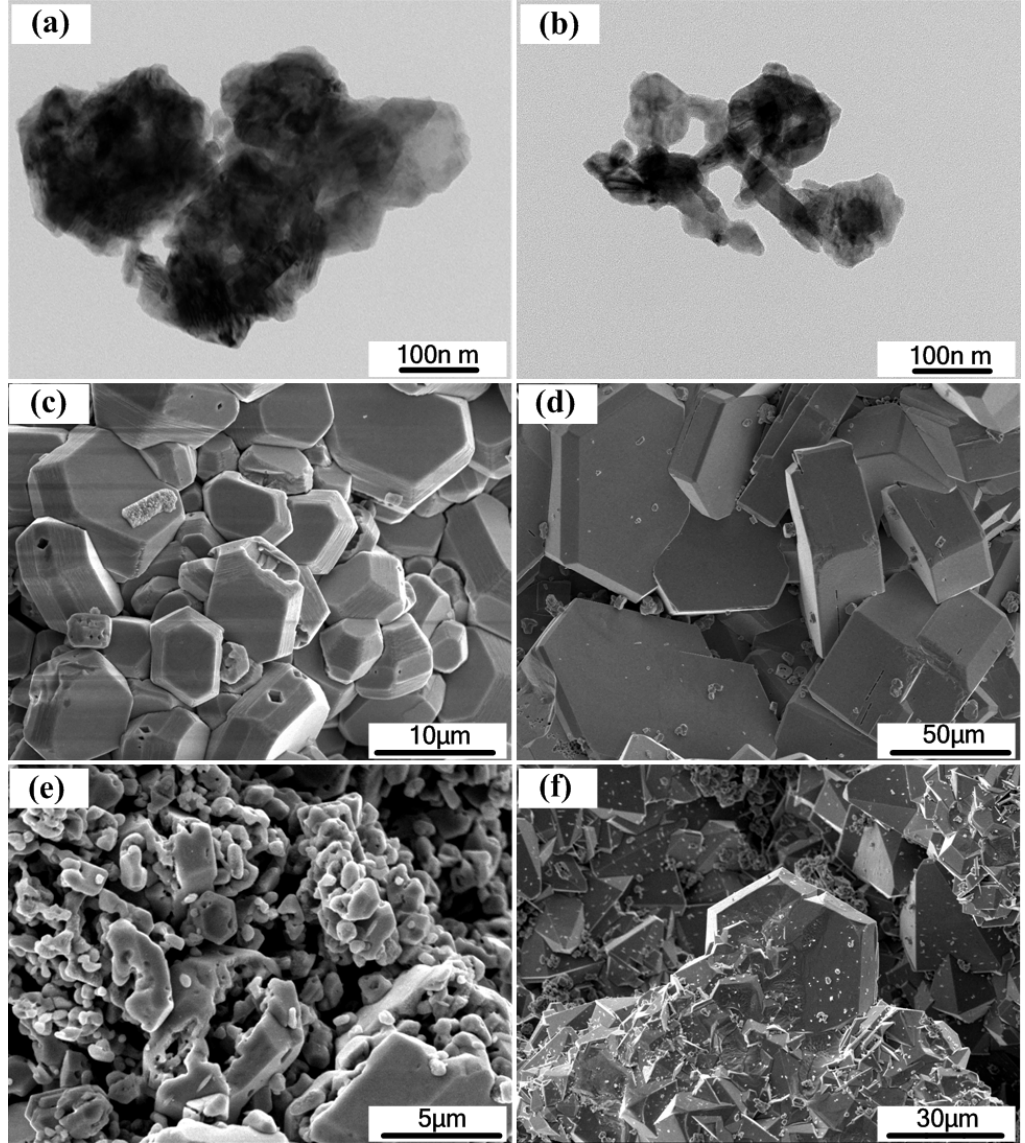
Figure 3. The TEM images of ( a , b ) raw GaN powders and The SEM images of typical GaN crystals obtained with N2 pressure of ( c ) 3.6 MPa inside the melt, ( d ) 3.6 MPa near the surface, ( e ) 4.5 MPa inside the melt, ( f ) 4.5 MPa near the surface.